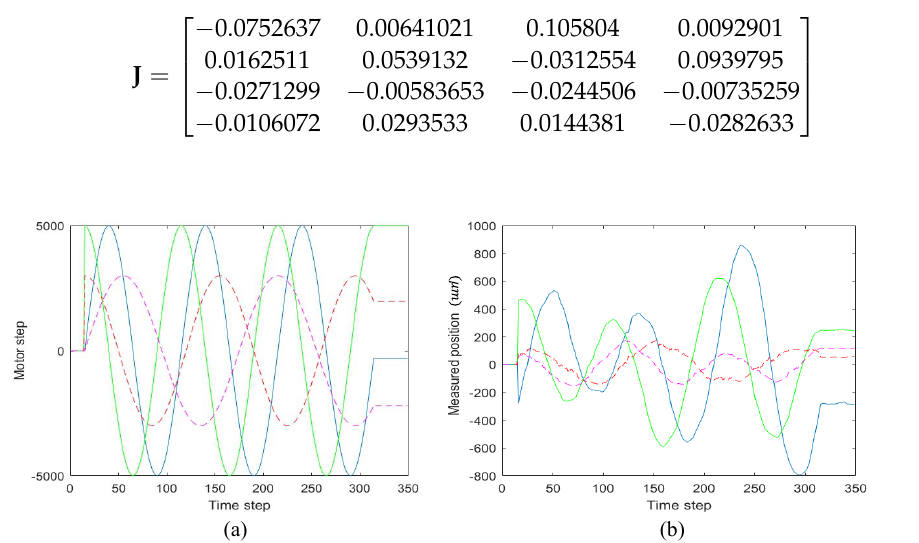
Figure 5. Active motion based data collection for kinematic calibration. ( a ) Motor steps by active motions. ( b ) Measured positions by active